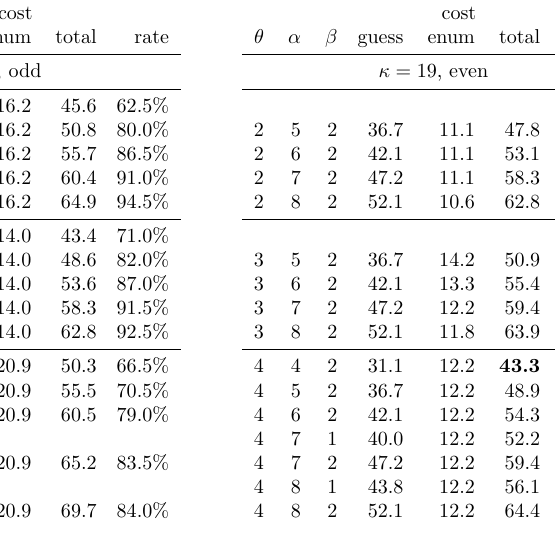
Table 9: Experimental results for Kyber parameters and κ = 19 ( ρ 0 = 1 . 0%, ρ 1 = 0 . 1%). For details see Table